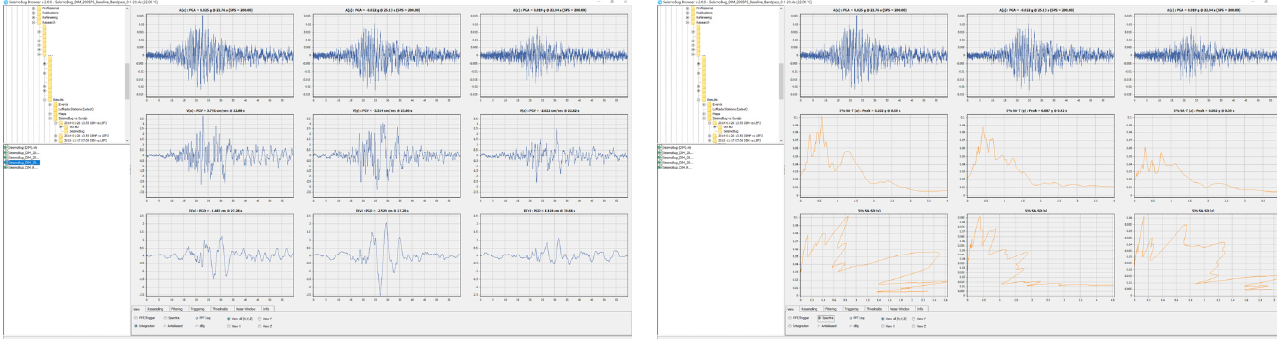
Figure 5. The SeismoBug © Browser software.